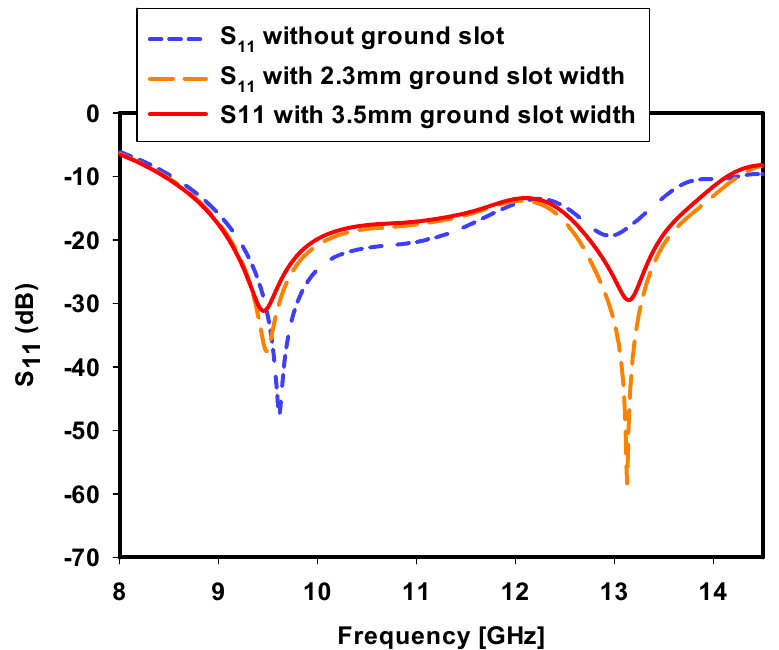
Figure 6. Effect of variation in the ground slot on the reflection coefficient.